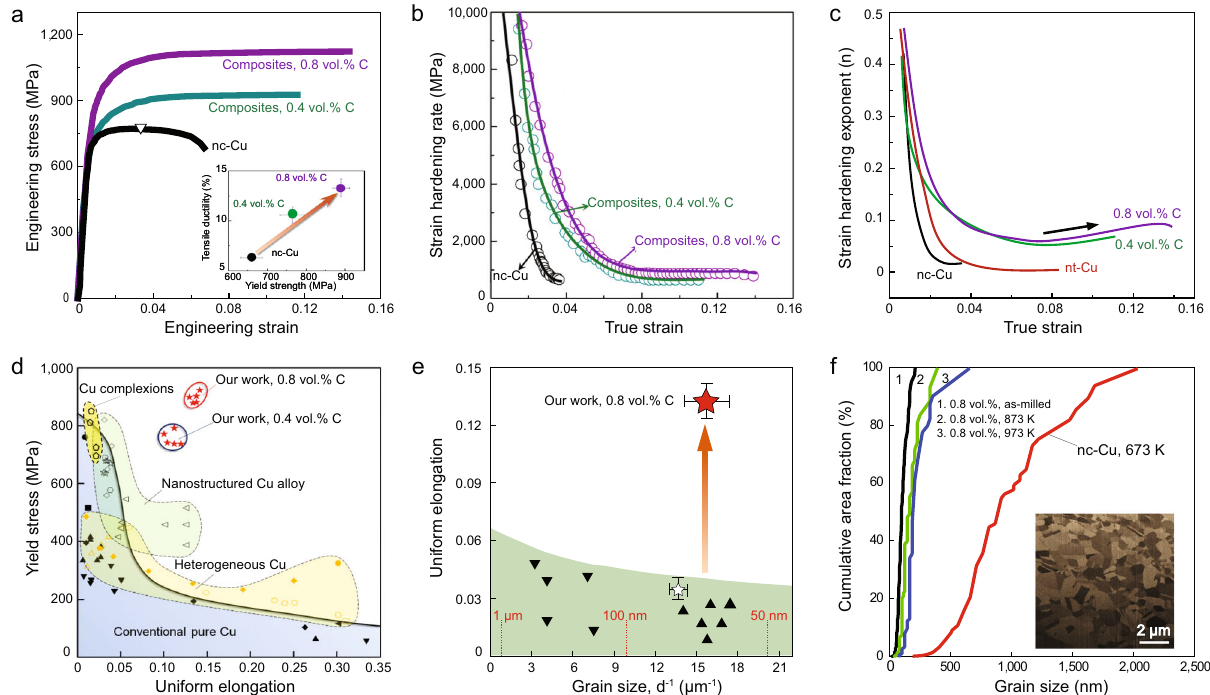
Fig. 3 | Tensile properties and thermal stability of nc-Cu composites. a Representative tensile engineering stress-strain curves for pure nc-Cu and nc-Cu composites (0.4 vol.% and 0.8 vol.% C, respectively). All tensile tests were per- formed at a strain rate of 5×10 − 4 s − 1 and room temperature. The strain at which neckingoccursismarkedwithanopentriangleforpurenc-Cu.Theinsetshowsthe simultaneous improvement of yield strength and uniform elongation of nc-Cu composites over pure nc-Cu. b Experimentally measured strain hardening rate d σ / d ε (with σ and ε being the true stress and true strain, respectively) for nc-Cu compositesandnc-Cu. c Strainhardeningexponent( n =d(ln σ ) / d(ln ɛ ))asafunction of strain. The reference nt-Cu plot was calculated from the literature 26 . d